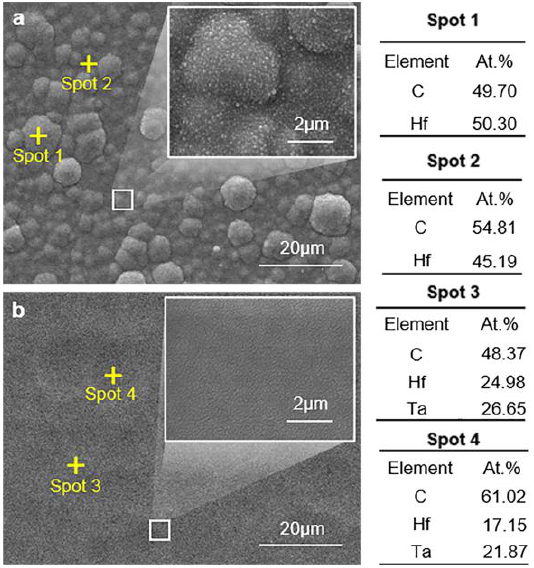
Figure 2. The surface topography of ( a ) HfC coatings and ( b ) HfTaC 2